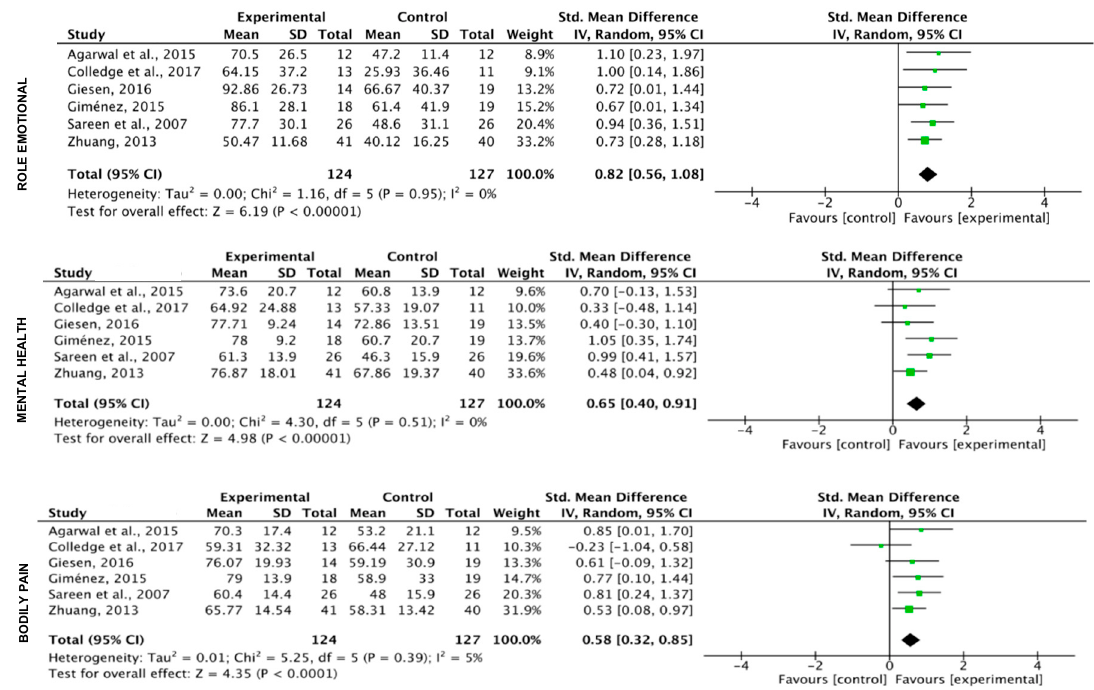
ff ect of the exercise on quality of life (all programs included). Figure 4. Effect of the exercise on quality of life (all programs included). Figure 4. E Figure 4. Effect of the exercise on quality of life (all programs included).